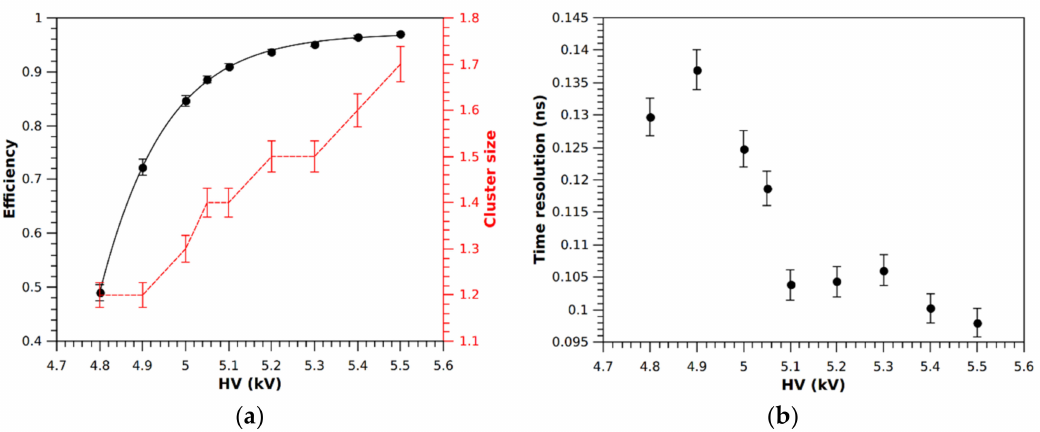
Figure 6. Cosmic test results of the high-rate sealed MRPC prototype: ( a ) the efficiency curve and cluster size; ( b ) the resolution of the flight time between the prototype and the T0 counter, with fluctuation from the readout chain